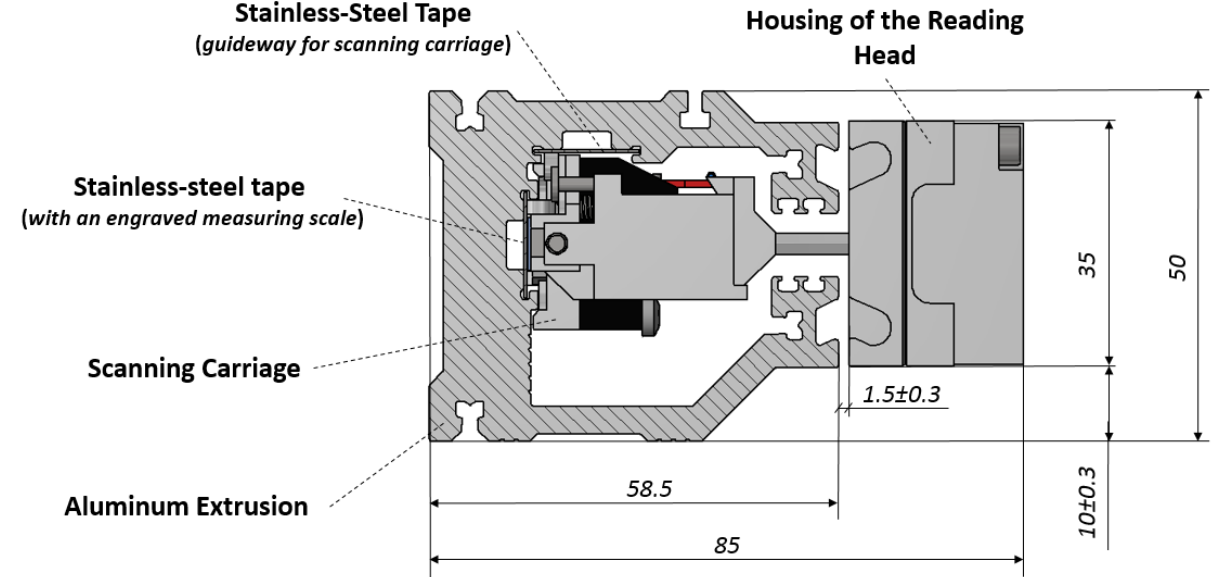
Figure 1. Cross-sectional view of the tested optical linear encoder LK50.